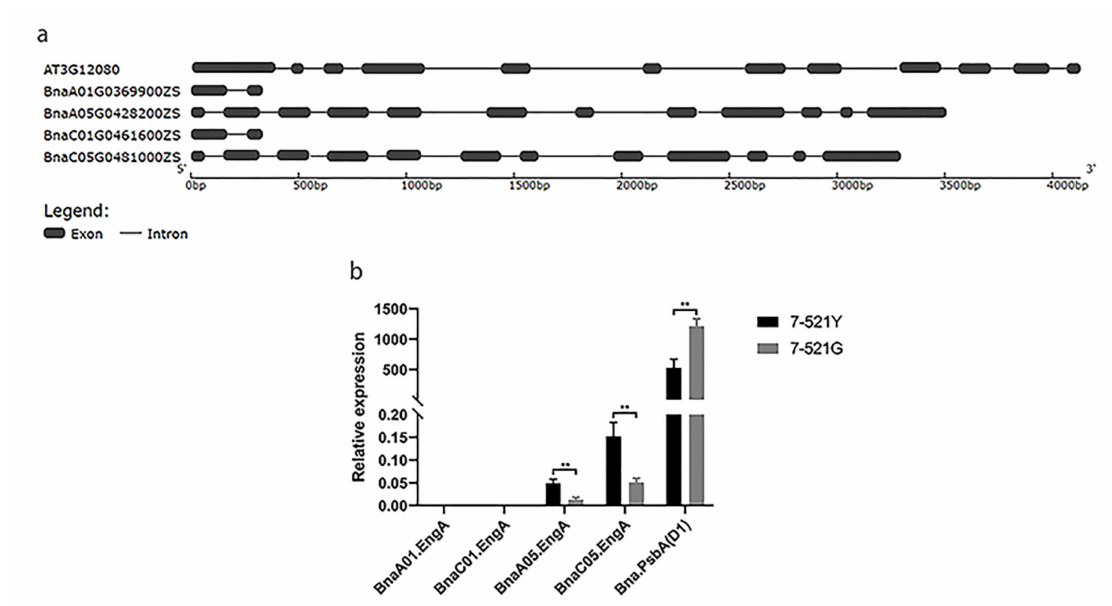
Figure 5. Expression levels of EngA and PsbA determined by qRT-PCR in Brassica napus . ( a ) Homologous gene structure analysis of EngA in B. napus . ( b ) Relative expression of EngA and PsbA homologous genes in B. napus . ** Denotes significant differences, p < 0.001, Student’s t